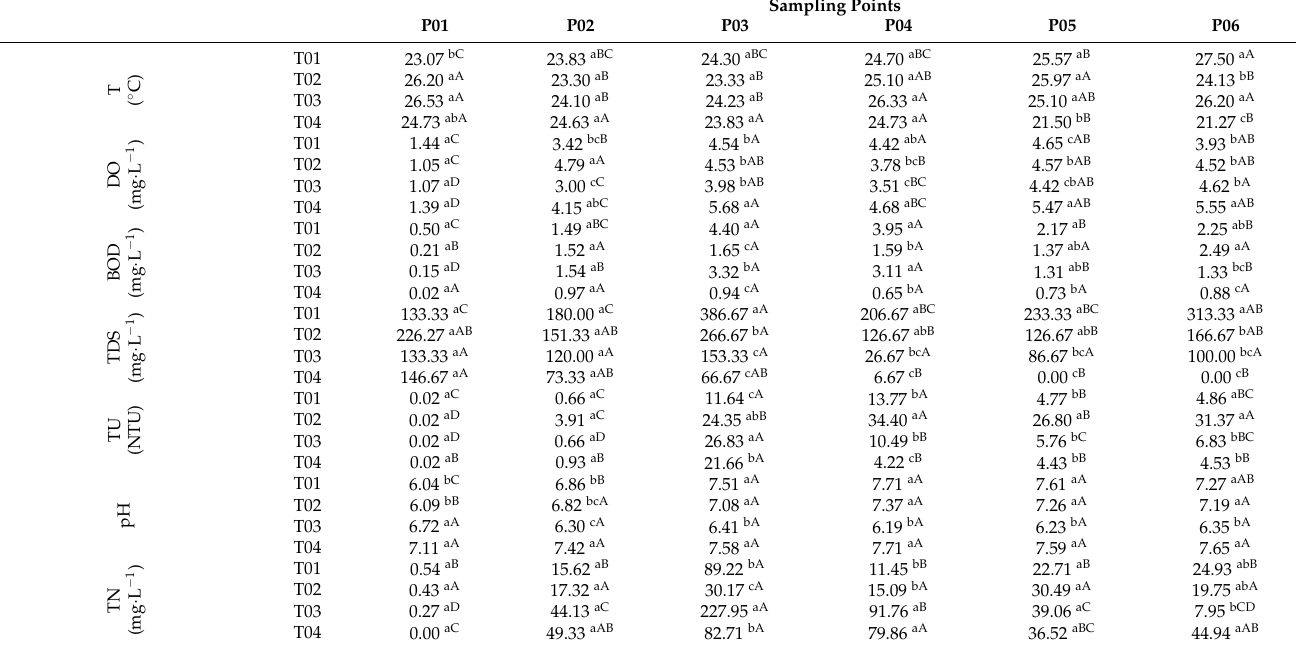
Table 4. Spatiotemporal effects on the water quality